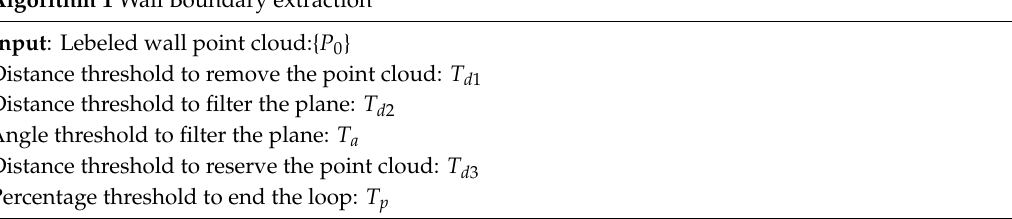
Algorithm 1 Wall Boundary